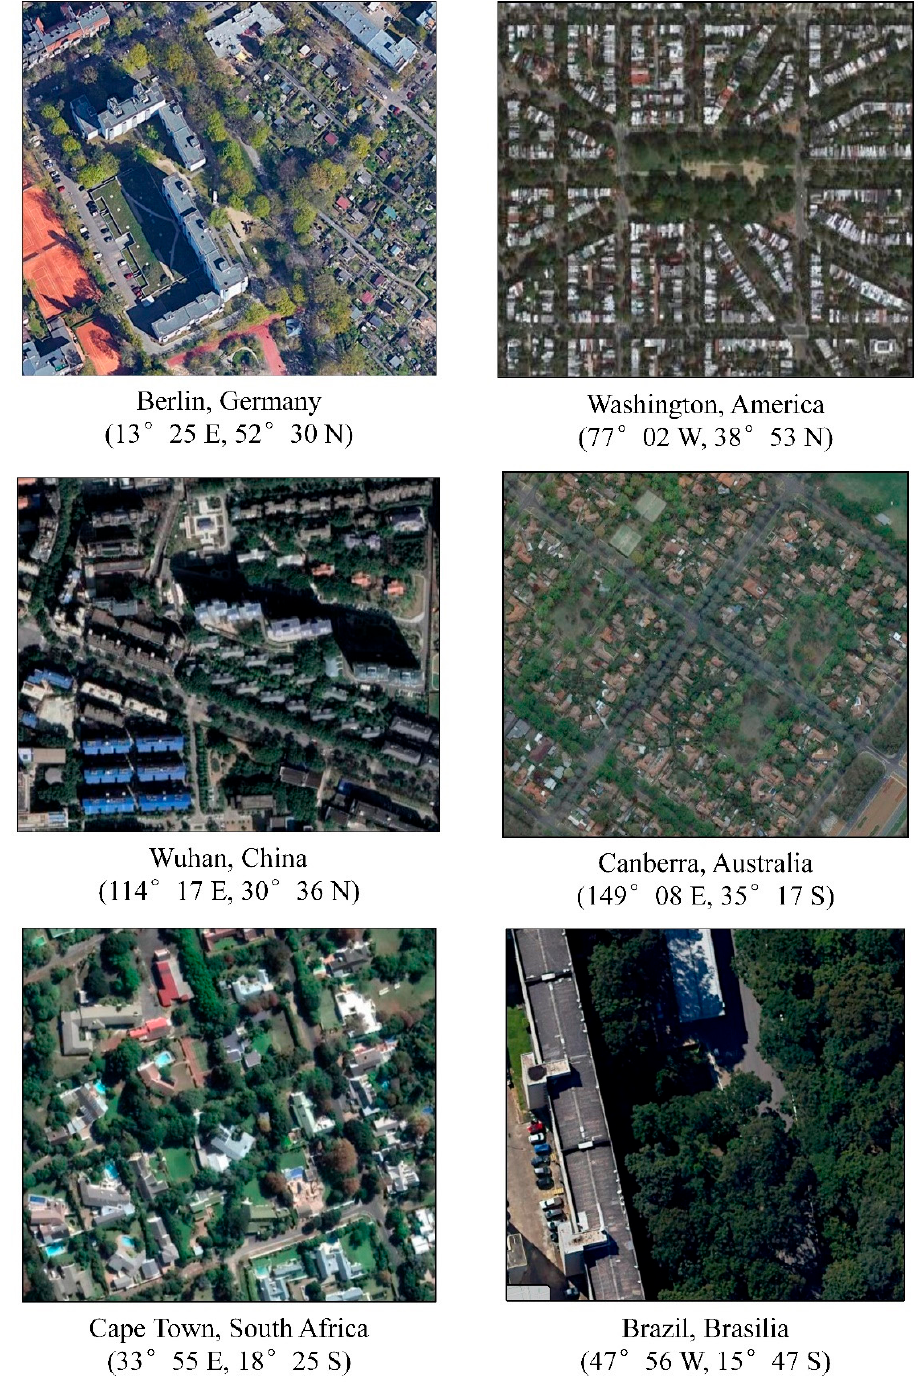
Figure 1. Vegetation obscuring effects in cities (from Google satellite map).